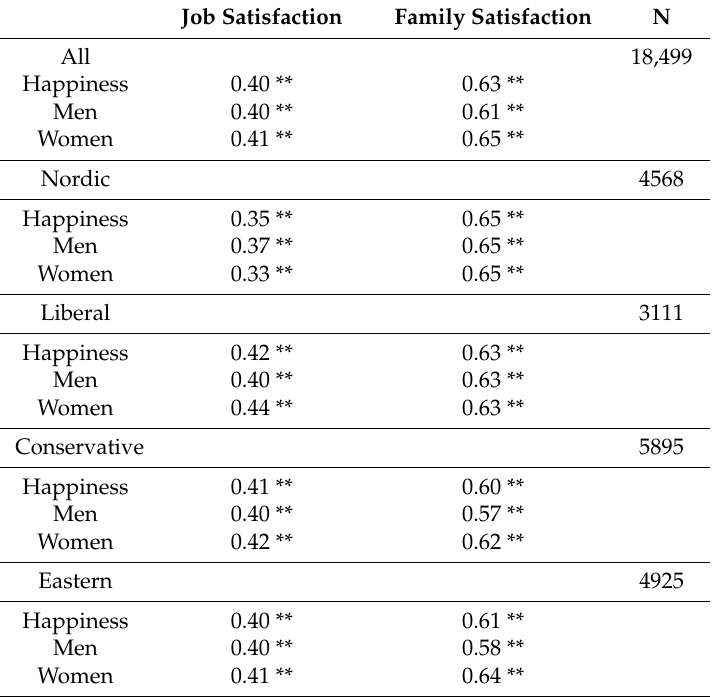
Table 3. Job satisfaction and family satisfaction by happiness among men and women in different gender regimes (Pearson).